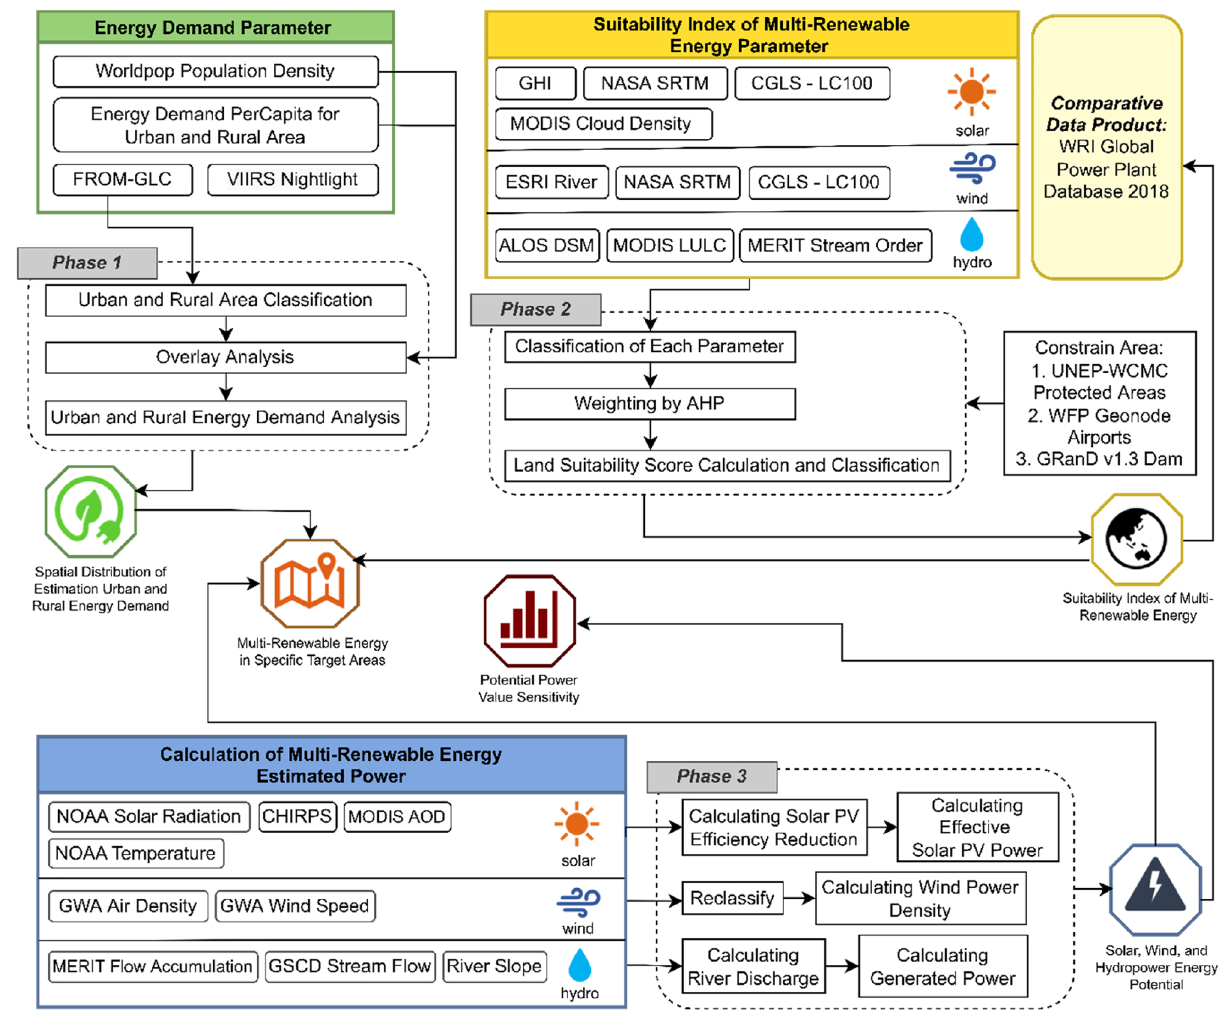
Figure 10. Flowchart of the methodology used in this